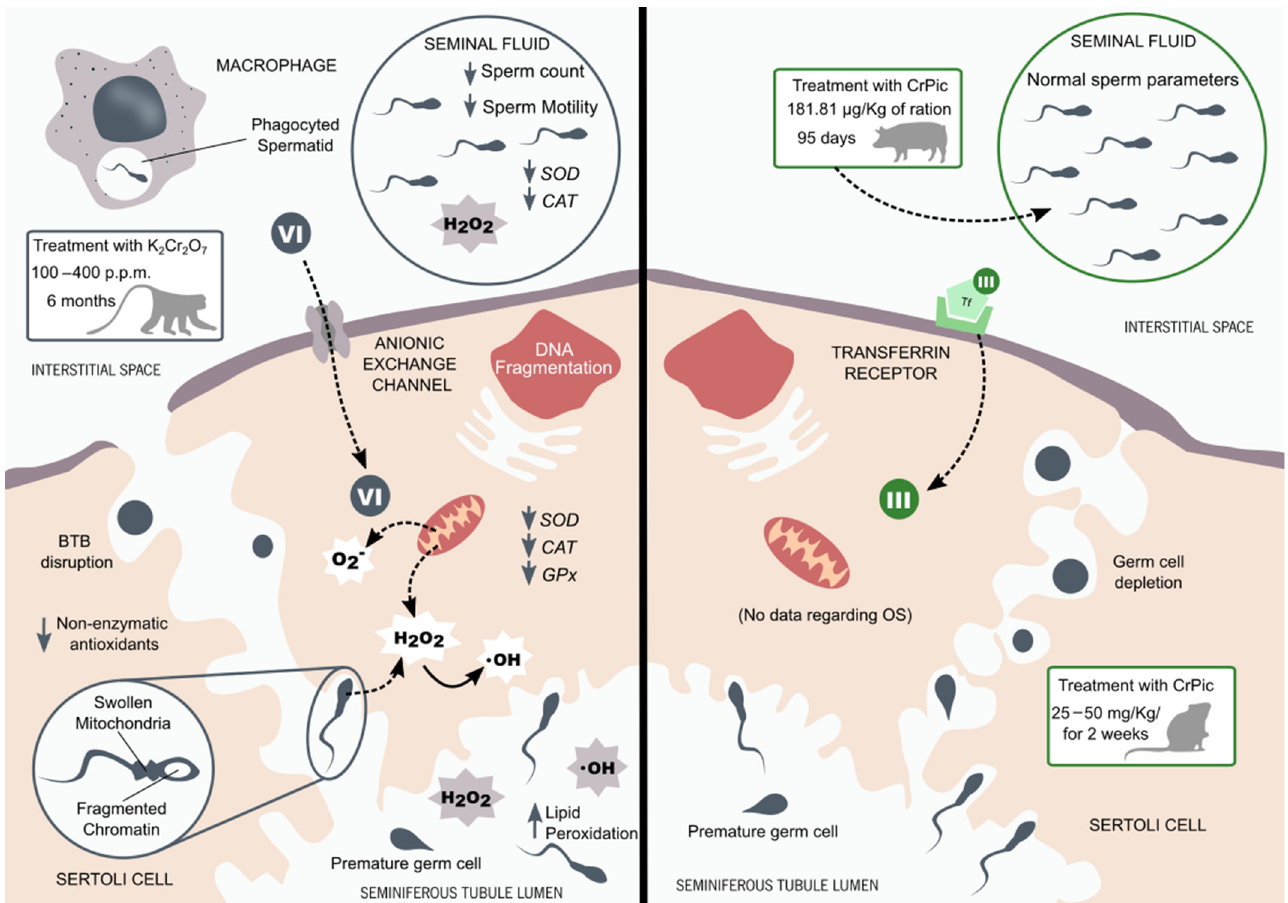
Figure 3. Chromium effects in males’ reproductive system. The Aruldhas M. and colleagues’ studies with Bonnet monkeys treated with potassium dichromate (K 2 Cr 2 O 7 ) reported a complete disruption of spermatogenesis and blood–testis barrier (BTB). Spermatids had fragmented chromatin and swollen mitochondria. The activity of testicular antioxidant enzymes was decreased, along with the concentration of non-enzymatic antioxidants. Meanwhile, levels of hydrogen peroxide (H 2 O 2 ) and hydroxyl radical ( · OH) increased with the chromium (VI) treatment. The authors also reported a decrease in SOD and CAT activities in both sperm and seminal plasma. Decreased sperm count and motility could be found in the semen of treated animals [90,107]. It is suggested that chromium (III) promotes its deleterious effects through the induction of oxidative stress (OS) in the testicular tissue. The treatment of CD1 mice with chromium picolinate (CrPic) by Ferreira M. and colleagues reveals degeneration of the seminiferous tubules, depletion of germ cells, and sloughing of immature germ cells [101]. However, the supplementation of breeding boars with CrPic performed by Hork ý P. and colleagues reveals no alterations in the semen quality of these animals [103]. No data have been found on the impact of chromium (III) on the oxidative balance of the testicular